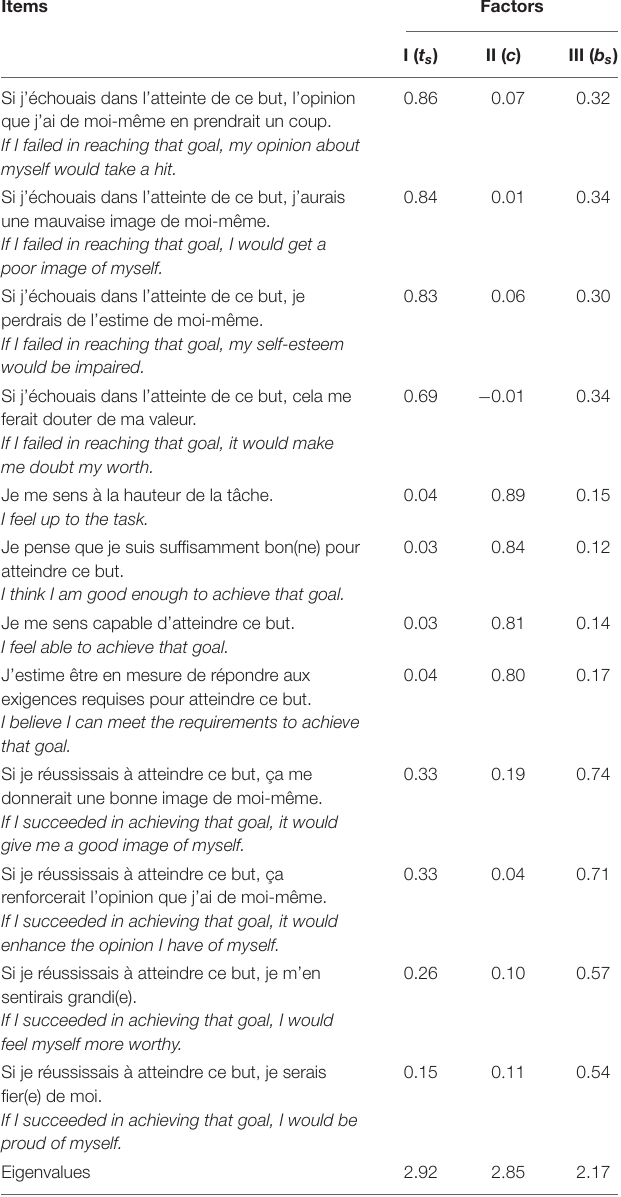
TABLE 1 | Items (French and English free translation), factor loadings and eigenvalues per factor resulting from the exploratory factor analysis with direct oblimin rotation ( n = 666).